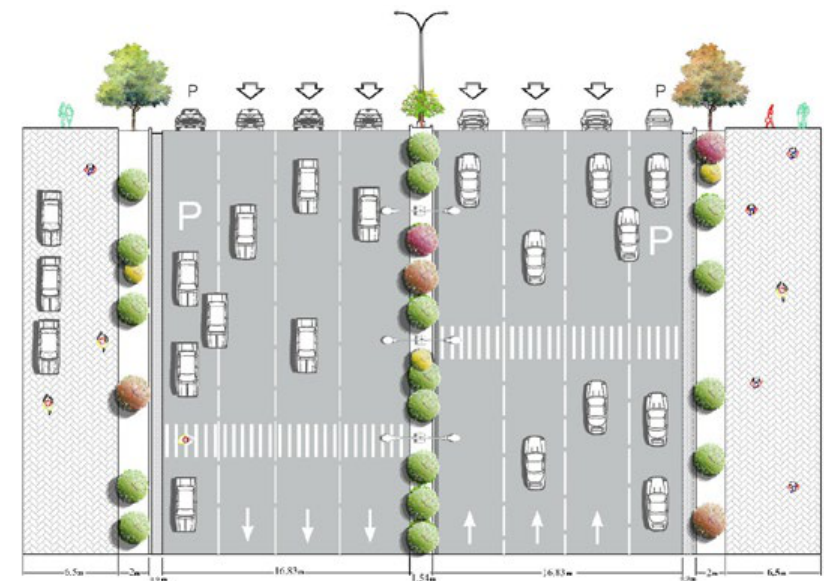
Fig. 2. Plan and cross section of current status of Jomhuri street Fig. 3: Improving the sidewalk infrastructure